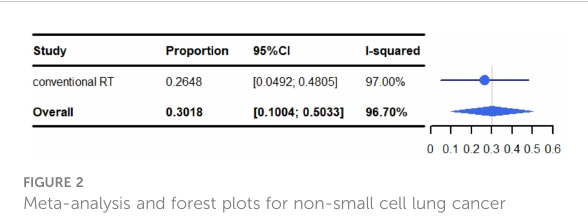
FIGURE 2 Meta-analysis and forest plots for non-small cell lung cancer